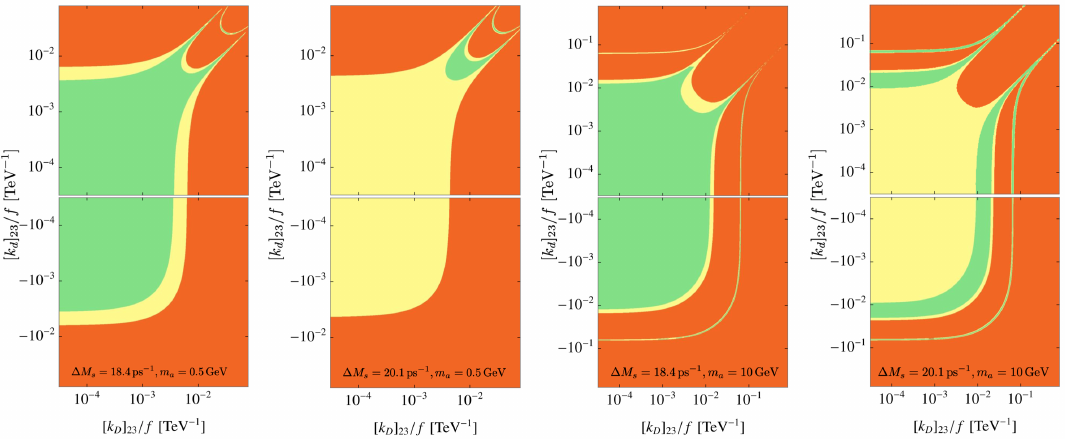
Figure 14 . ALP couplings for which the mass difference ∆ M s is reproduced within 1 σ (green) or 2 σ (yellow) for m = 0 . 5 GeV (two left panels) and m = 10 GeV (two right panels) using recent a a weighted averages (first and third panels) and FLAG 2019 values (second and fourth panels) for the SM prediction. The orange region is excluded at 2 σ